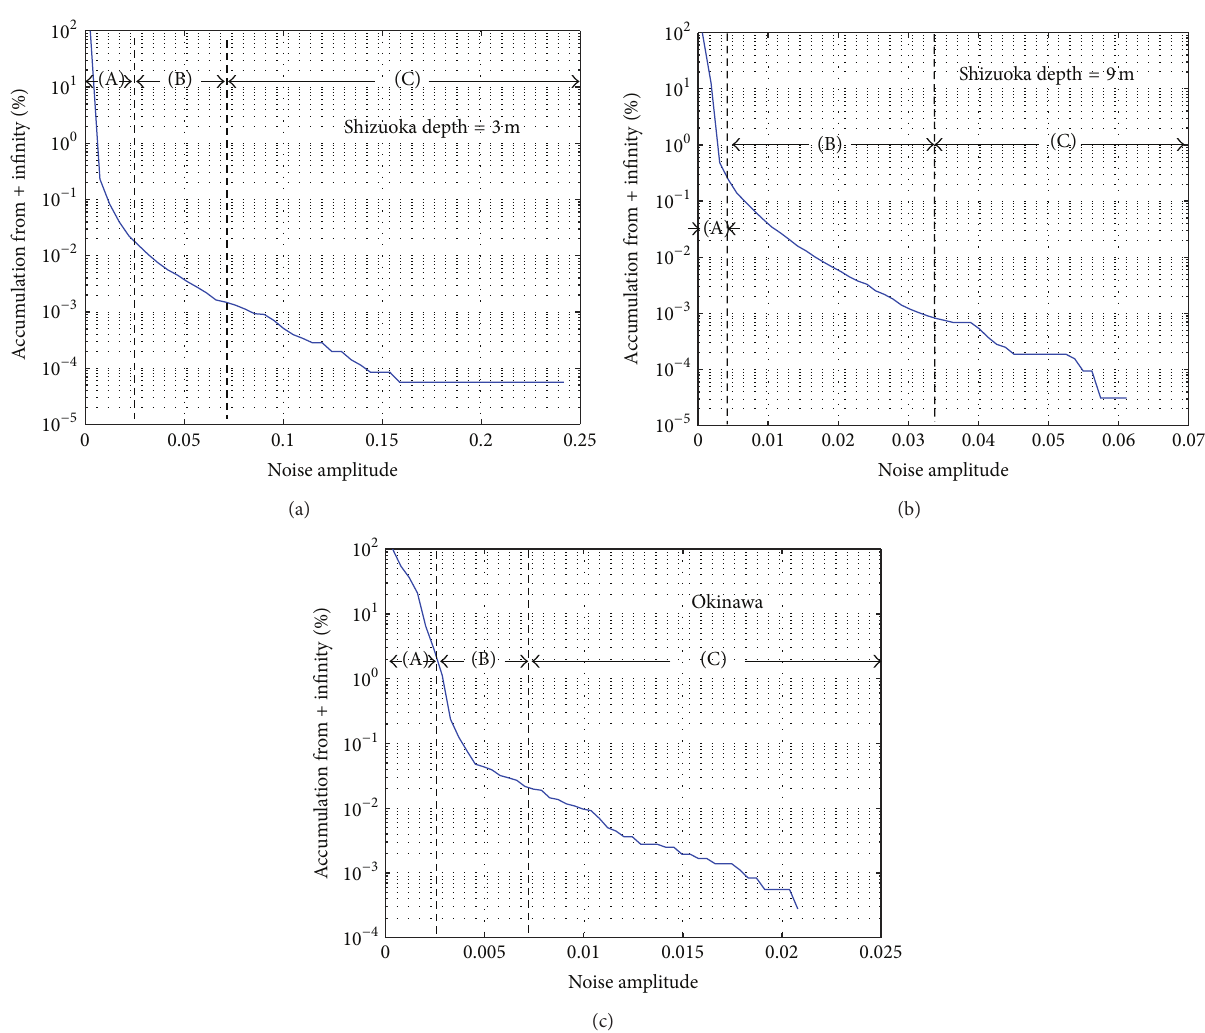
Figure 5: (a) Accumulated background noise from + infinity at Shizuoka (depth = 3m). (b) Accumulated background noise from + infinity at Shizuoka (depth = 9 m). (c) Accumulated background noise from + infinity at